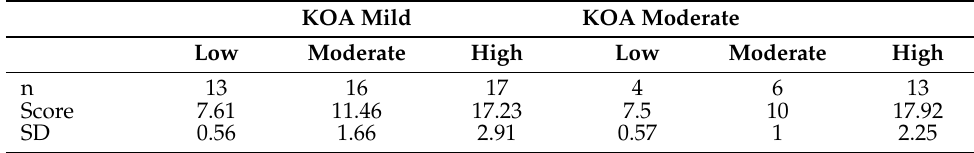
Table 2. Short FES-I sample